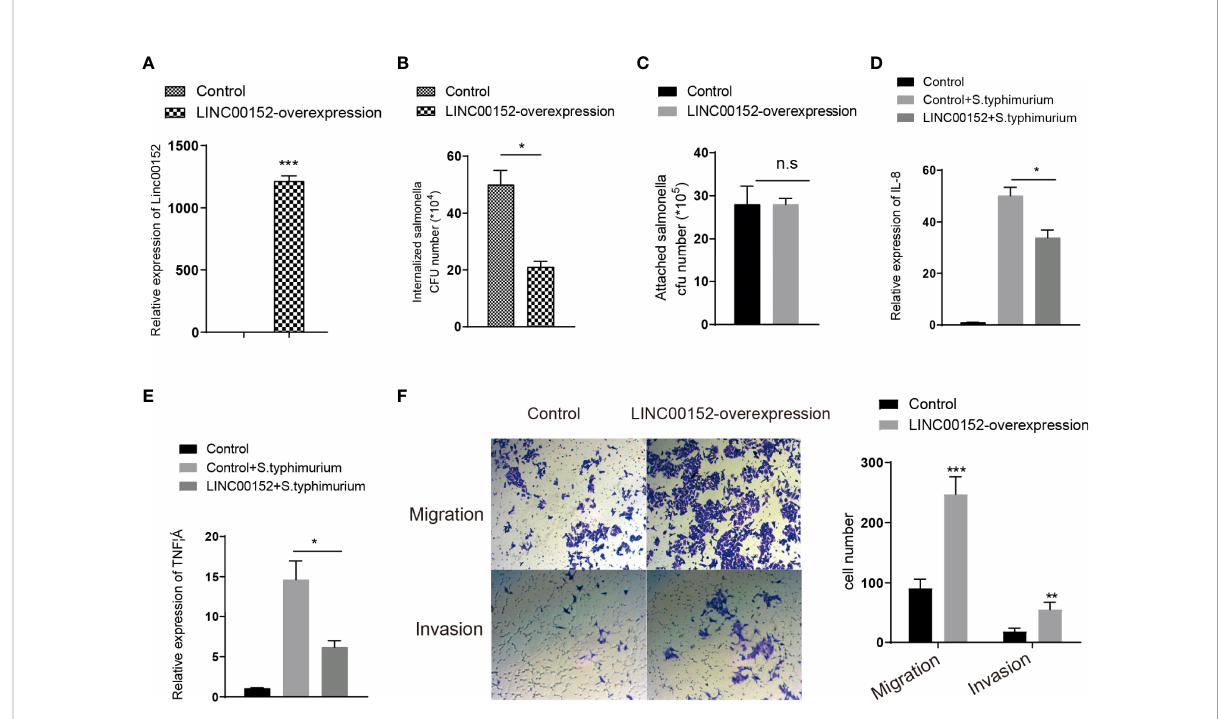
FIGURE 2 LINC00152 is involved in the S. typhimurium- introduced in fl ammation and cancer cell invasion and migration. (A) The expression level of LINC00152 in the control and overexpressed stalely cells. (B) LINC00152 overexpressed cells had fewer internalized Salmonella . (C) The number of bacteria attachment with cells in control and LINC00152-overexpressed cells . (D, E) The expression level of IL-8 and TNF a were reduced in the LINC00152 overexpressed cells compared with control HCT116 cells infected with S. typhimurium . (F) The migration and invasion of LINC00152 overexpressed HCT116 cells. All experiments were in three replicates. * P < 0.05; ** P < 0.01; *** P < 0.001; n.s: not signi fi